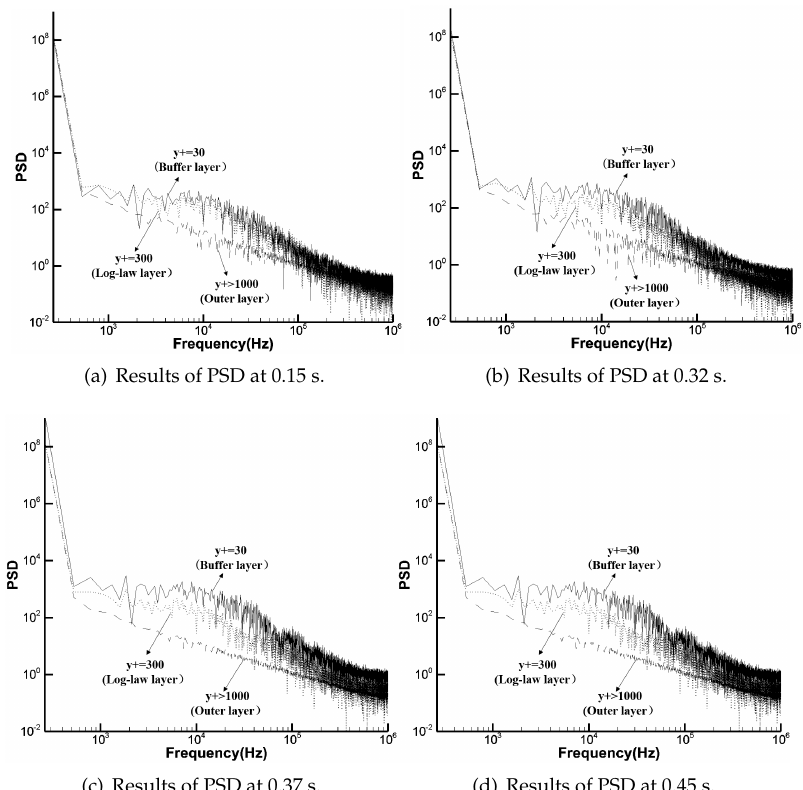
Figure 2. Time-independent